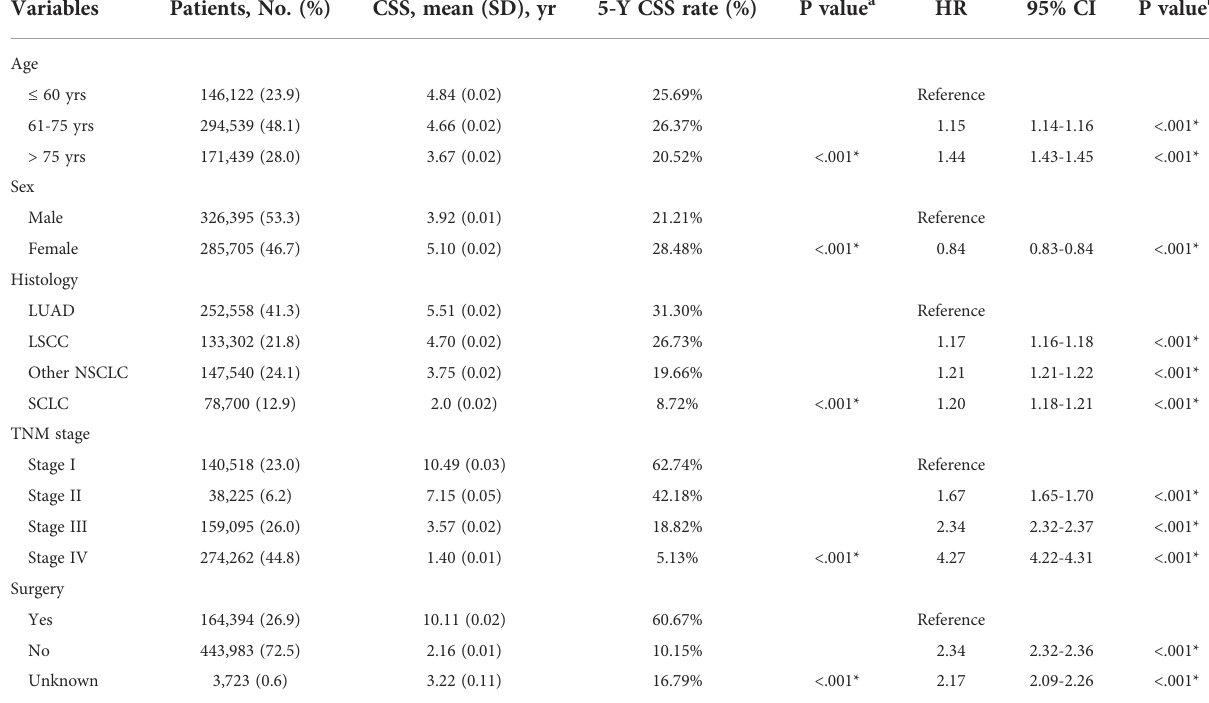
TABLE 2 Cancer-speci fi c survival